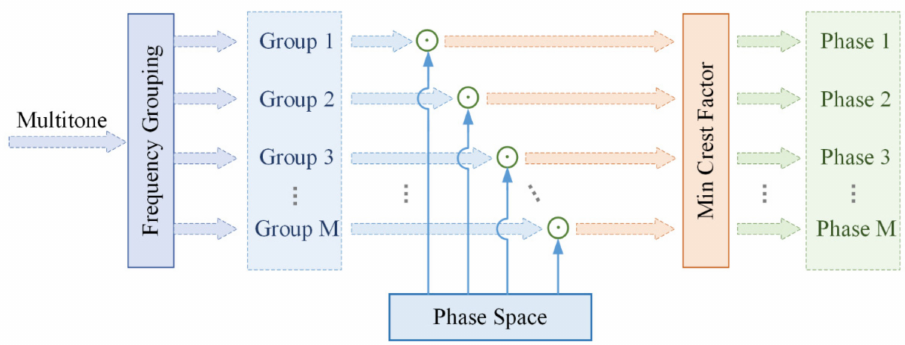
Figure 2. Flow diagram of the grouping search